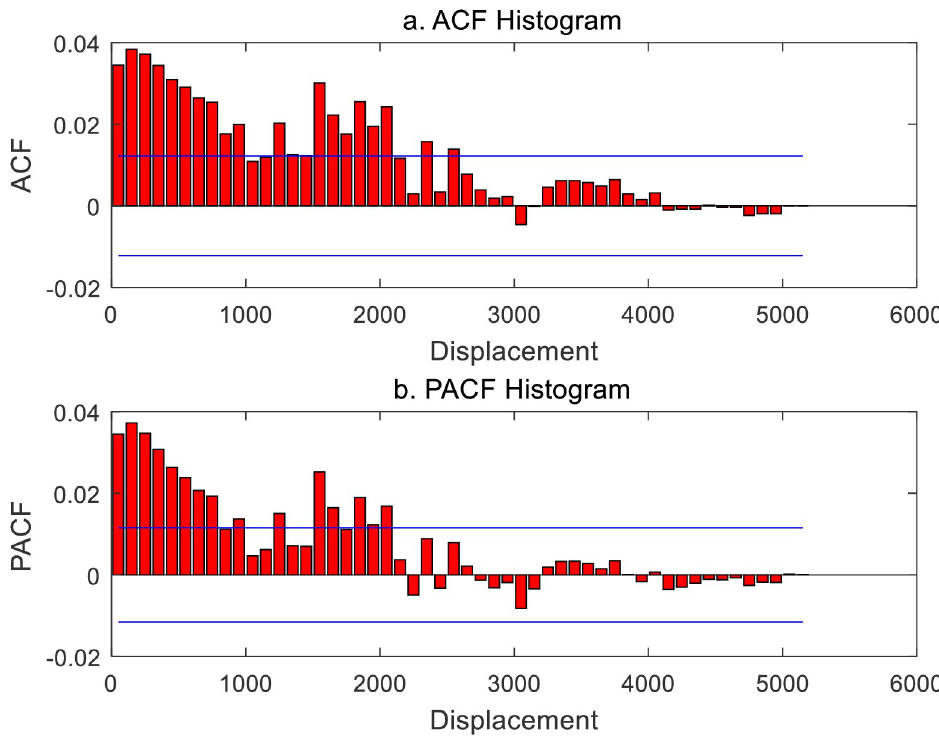
Fig 2. Spatial autocorrelation function and partial autocorrelation function of Chinese cities based on generalized Moran’s index and correlation cumulation (2000). ( Note : The blue lines in the histograms are termed “two- standard-error bands”, according to which we can know whether or not there is significant difference between ACF or PACF values and zero. The same below.).